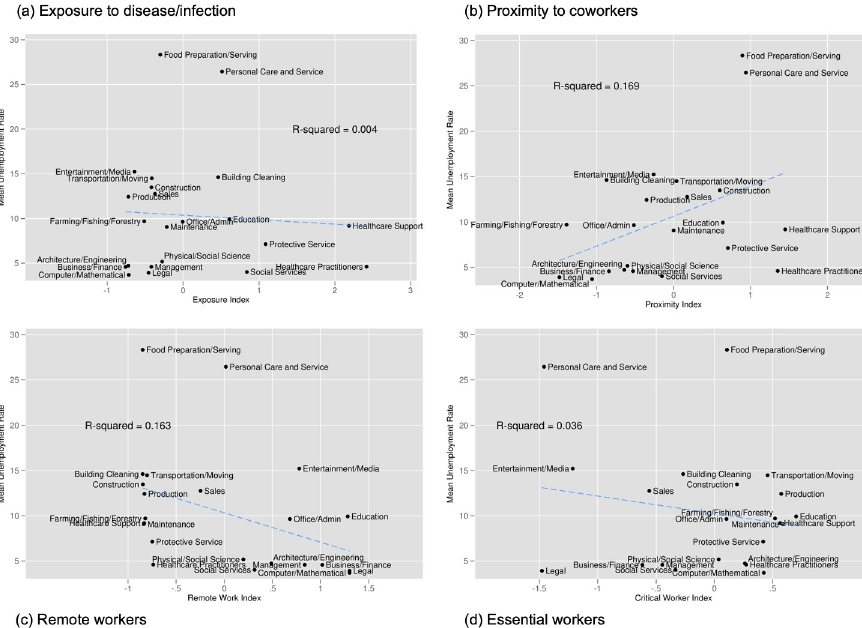
Fig 6. Unemployment by index and occupation. Notes: Unemployment data are from Current Population Survey, indexes are calculated by authors using data from O � NET, LMI, and [1]. The x-axis indicates the index value while the y-axis indicates the average unemployment rate from March 2020 through June 2020. Each dot is a major occupation category (a two digit SOC code). Index values are normalized to mean 0 and standard deviation 1.